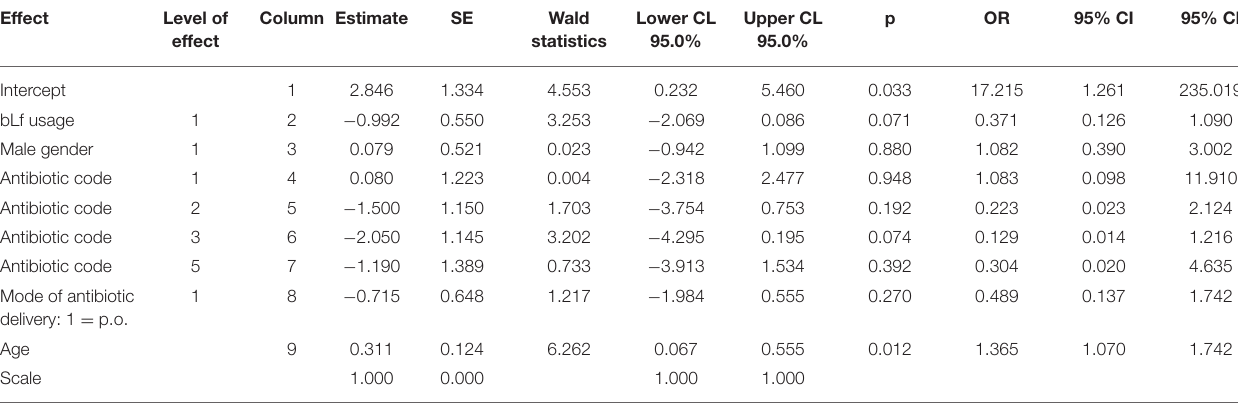
TABLE 4 | Logistic regression analysis results in regard to different levels of